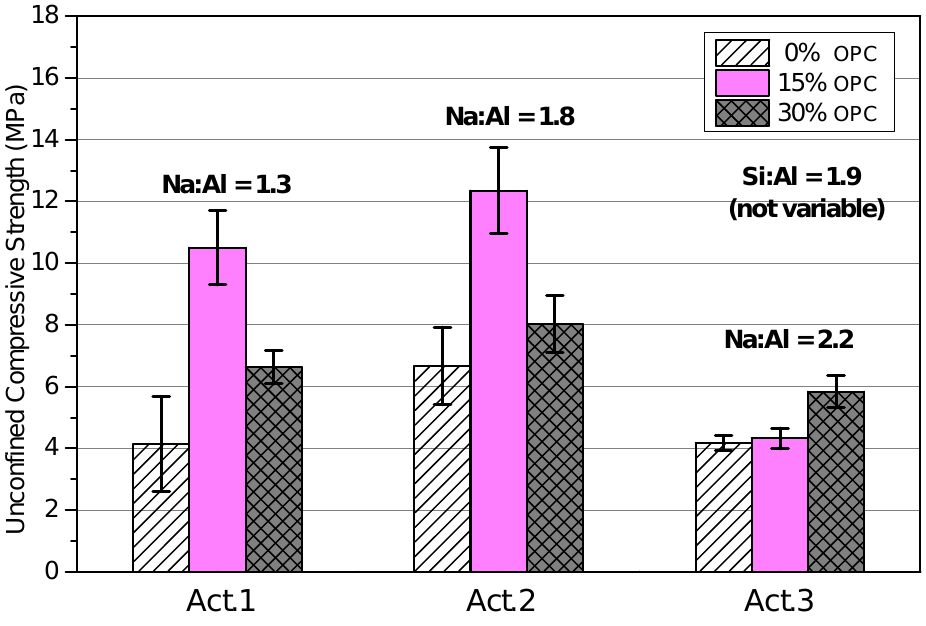
Figure 6. UCS vs. Activator (Act.) bar graph of alkali-activated cement (AAC). Yliniemi et al. [42] reported that using sodium aluminate kinetically retards the SW reaction when compared with using sodium hydroxide and sodium silicate. These